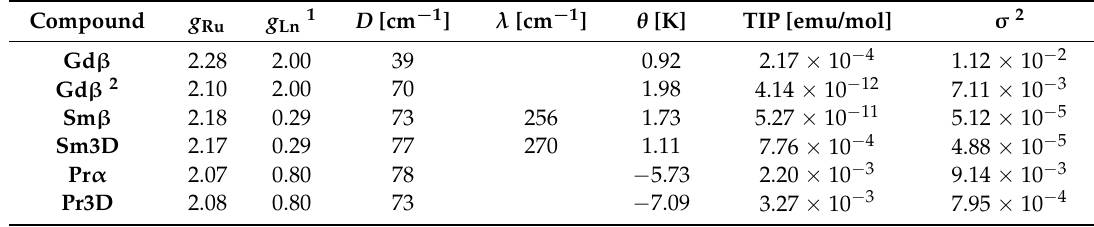
Table 2. Magnetic parameters obtained for the fit of the magnetic data.